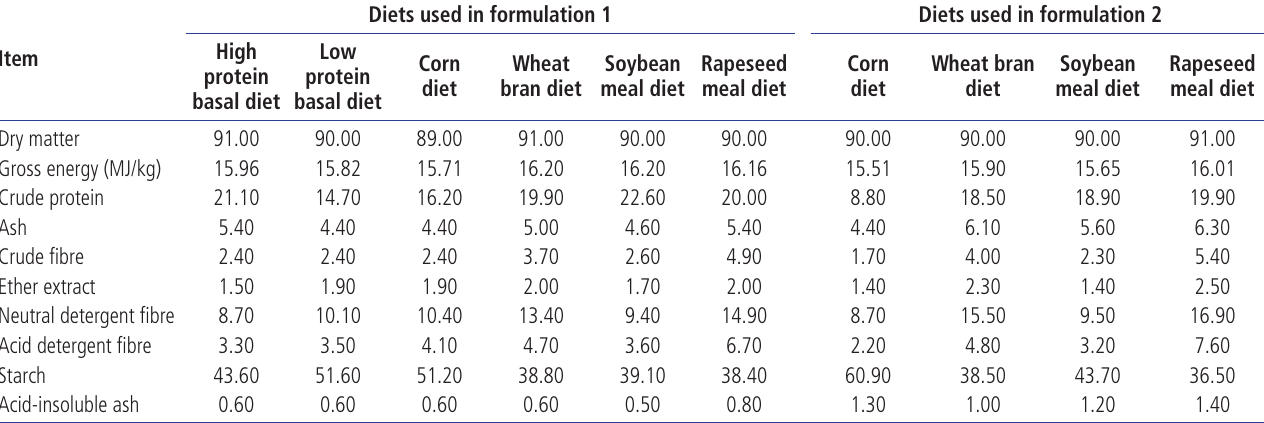
Table 2. Analyzed composition of the experimental diets (% as fed basis) 1)